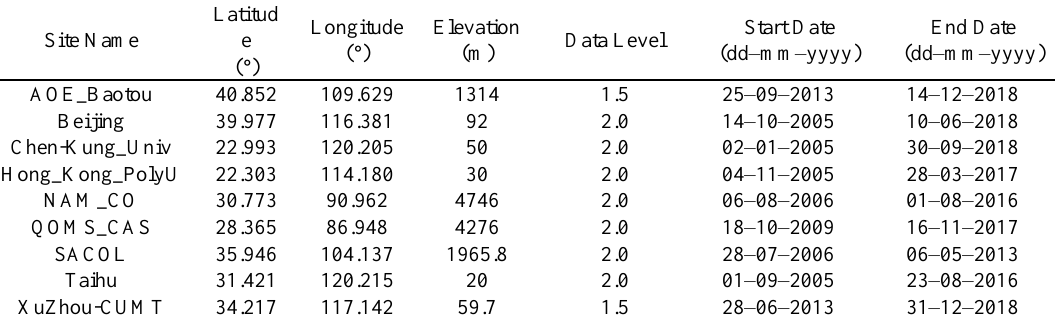
Table 1. Informations of nine AERONET sites used in this